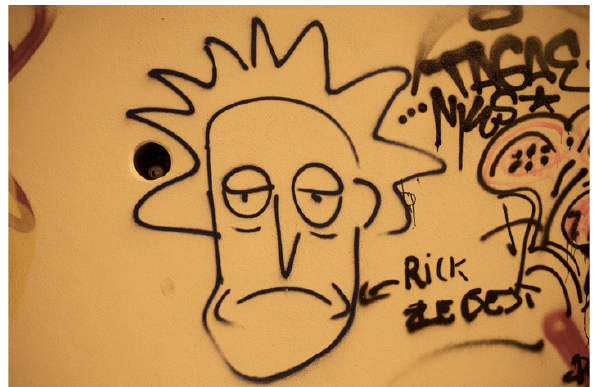
Figure 12. Photograph extracted using the keyword “Graffiti” in the city of Lisbon (Flickr, 2018d), which true location was not identified.